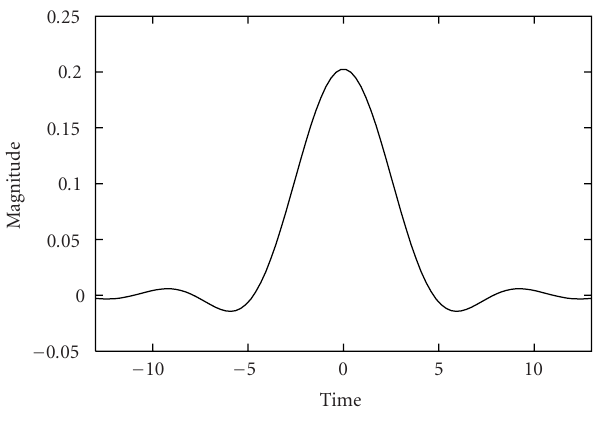
Figure 4.7. Halfcos continuous function.